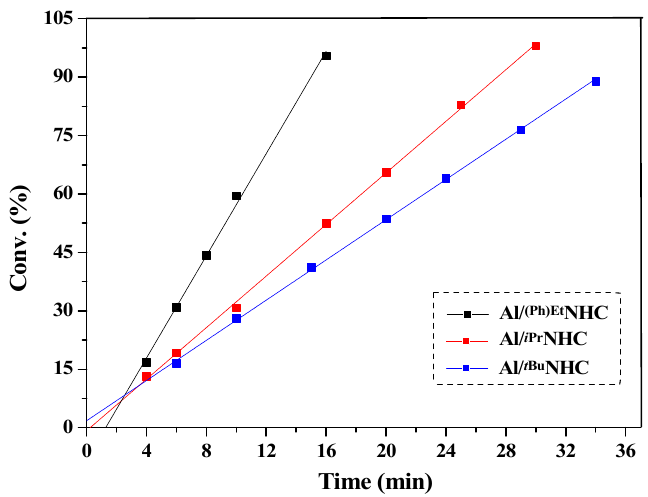
Figure 1. Conversion–time plots for the MMA polymerization by different Lewis pairs (LPs) in toluene at room temperature (RT).